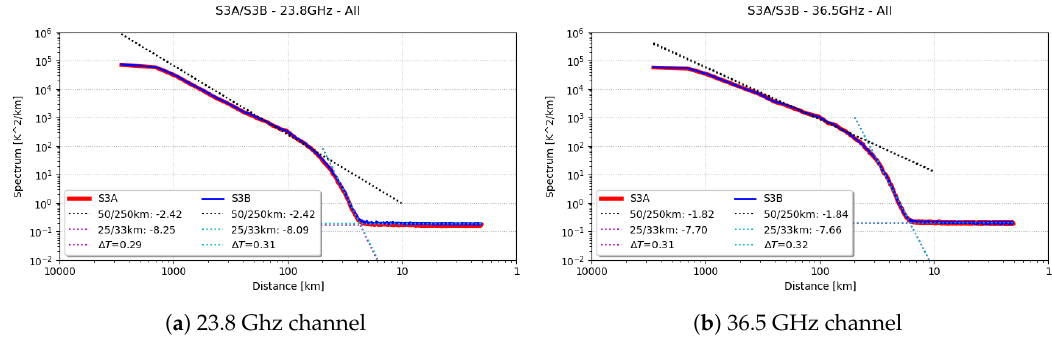
Figure 4. Brightness temperature spectra for both channels of S3A and S3B.